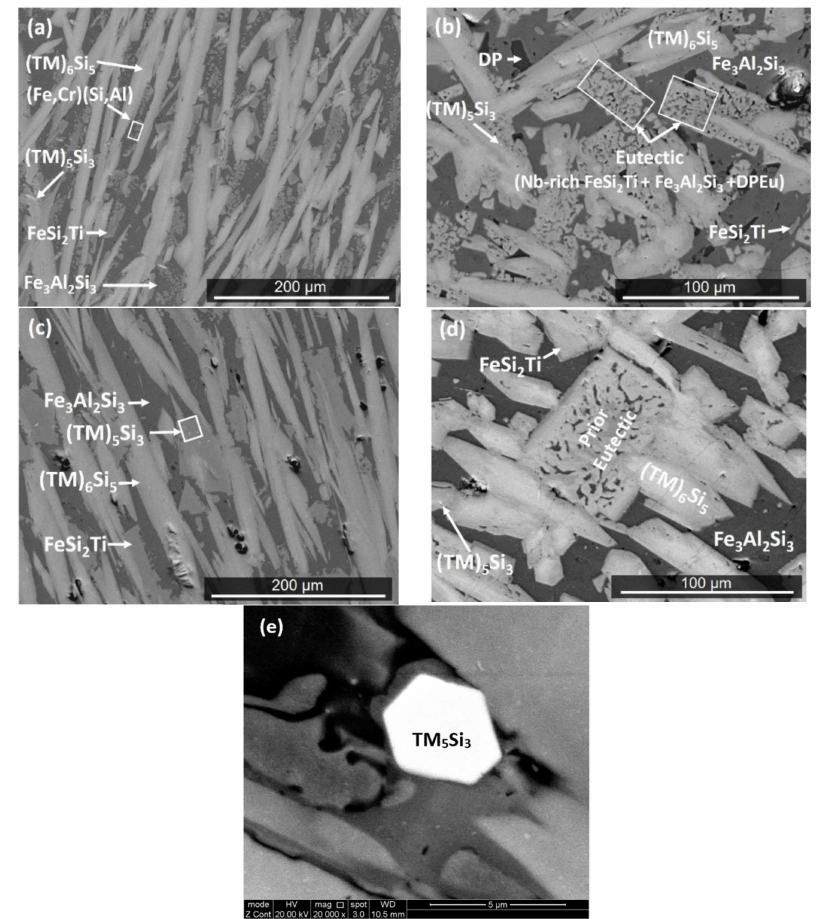
Figure 6. BSE images of the microstructures of the heat treated alloy, ( a , b ) OHC2-HTA, ( c , d ) OHC2-HTB, and ( e ) high magnification image of hexagonal TM 5 Si 3 particles in ( d